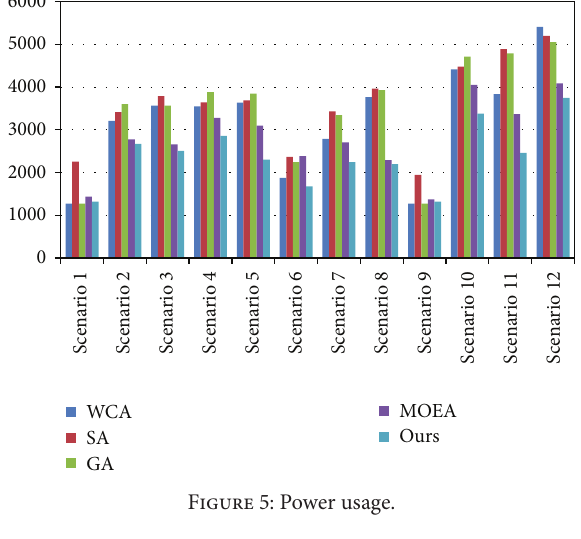
Figure 5: Power usage.